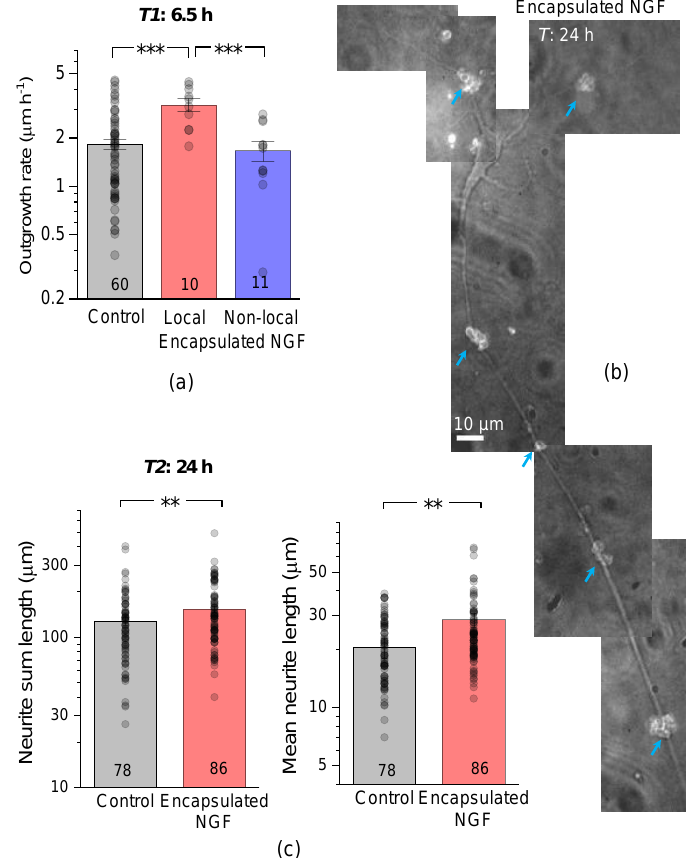
Figure 3. Encapsulated NGF elevates the neurite growth rate. ( a ) Average neurite length and the estimated outgrowth rate in control conditions and in the presence of encapsulated NGF for local (<50 µ m away from capsules) and non-local (>50 µ m away) cells, as indicated. ( b ) A snapshot of a pyramidal-like hippocampal neuron at 24 h, with the growth trajectory of its main neurites directed by the clusters of NGF-releasing capsules (blue arrows; TRITC microcapsule labelling). Image, merged DIC and TRITC fluorescence channels (grey-level). ( c ) Statistical summary of the total (sum) neurite length (left) and mean neurite length (right) per individual neuron, at 24 h post-plating in control cultures and in the presence of encapsulated NGF. Dots, individual cell data; bars, mean ± s.e.m; numbers of analysed cells shown; ** p < 0.01, *** p < 0.005 (two-tailed unpaired t -test); ordinate, log